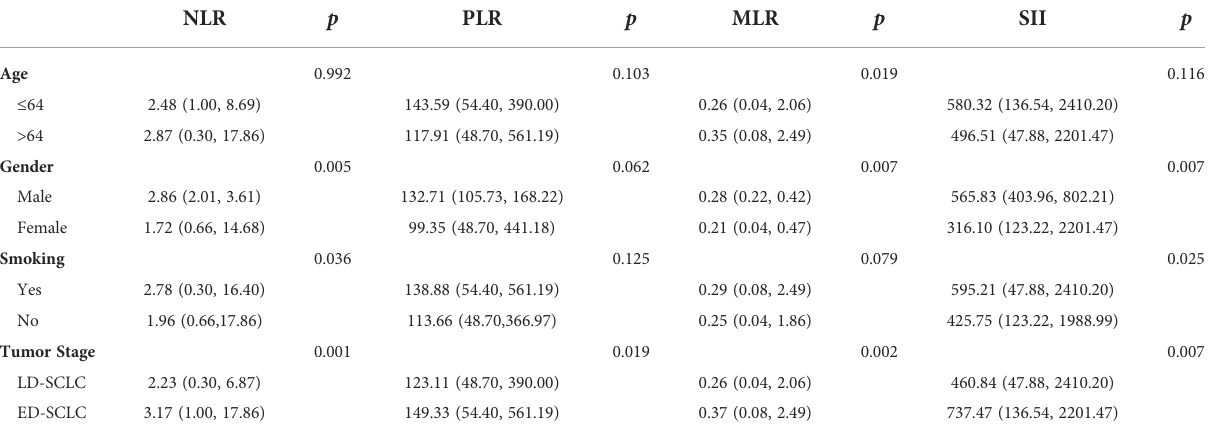
TABLE 2 Analysis of in fl ammatory markers in patients with SCLC ( n =